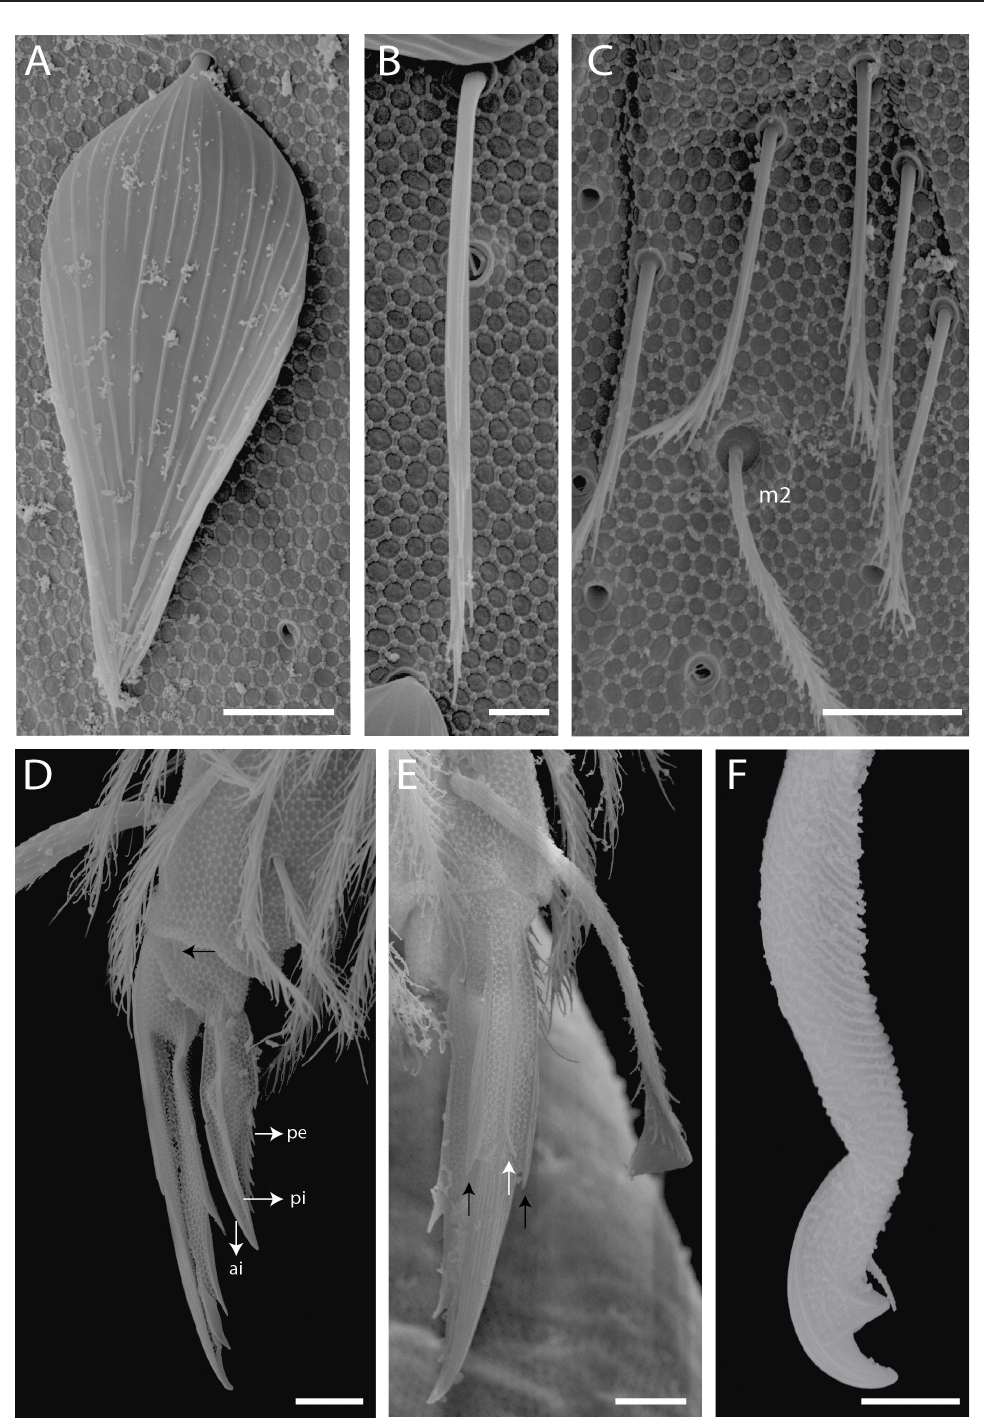
Fig. 3. Scanning electron microscopy of Willowsia nigromaculata (Lubbock, 1873). A . Scale apically pointed of Abd IV. B . Tergal microchaeta basally smooth and with ramification on distal half. C . Bothriotrichal complex of Abd II, m2 is bothriotrichum. D . Distal tibiotarsus and empodial complex I (posterior side), black arrow indicates pretarsal chaeta and white arrows indicates unguiculus lamellae. E . Distal tibiotarsus and empodial complex II (outer side), white arrow indicates unpaired basomedian tooth and black arrows indicates paired basolateral teeth of the unguis. F . Distal dens and mucro (lateral side). Abbreviations: see Material and methods. Scale bars: A, C–F = 5 μm; B = 2